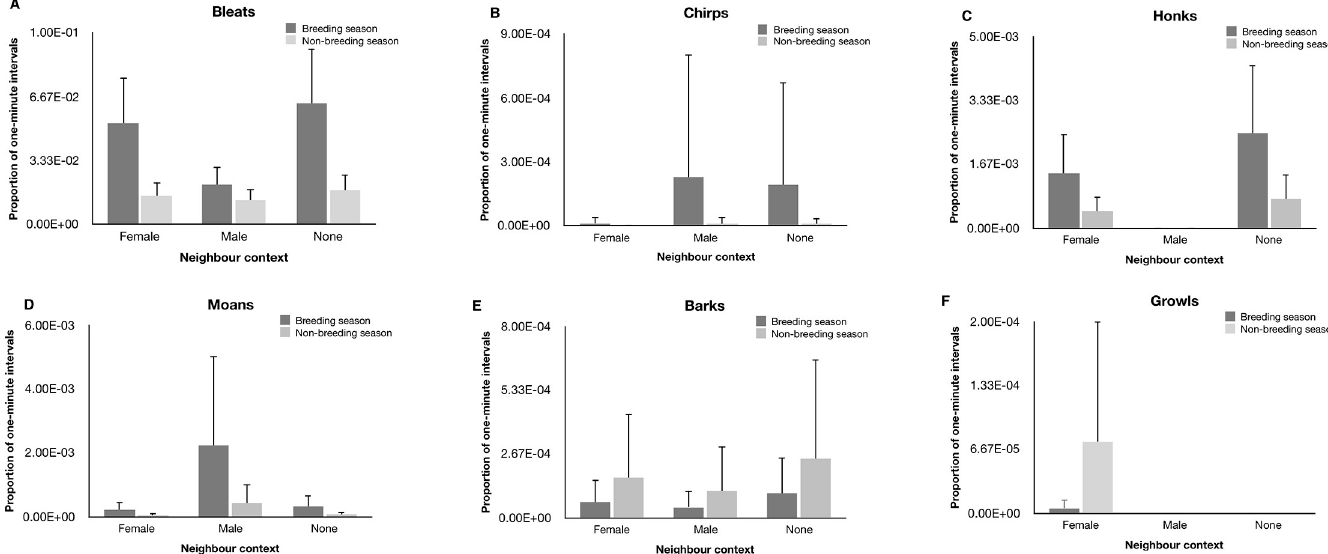
Fig 1. Error bar charts showing the effect of neighbour context on male vocal behaviour during and outside of the breeding season. Back-transformed estimated marginal means ± SE of the proportion of intervals in which males were (a) bleating, (b) chirping, (c) moaning (d) honking (e) barking (f) and growling during the 45 minute observation sessions are presented